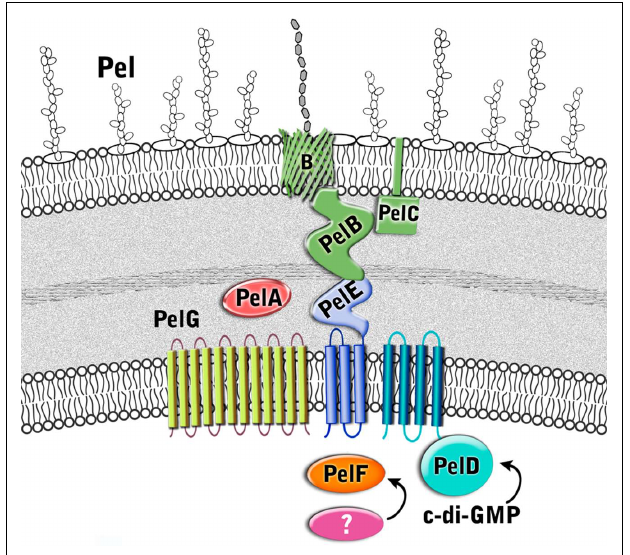
FIGURE 5 | Proposed structure of the Pel biosynthetic complex. The enzymes are color coded according to proposed function as described in Figure 3 .